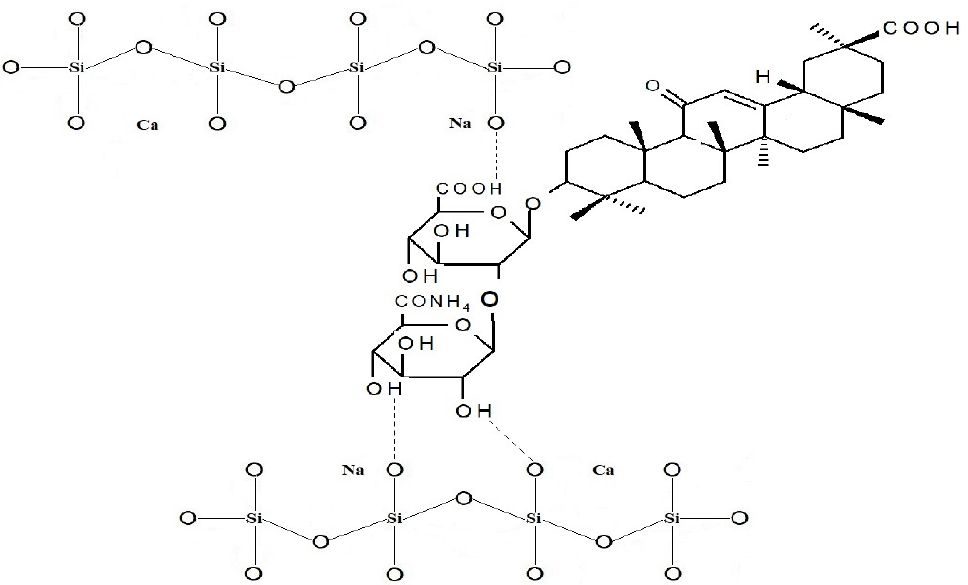
Figure 6. Proposed scheme of interaction between MSGA and BG’s structural units in the as- prepared hybrids.